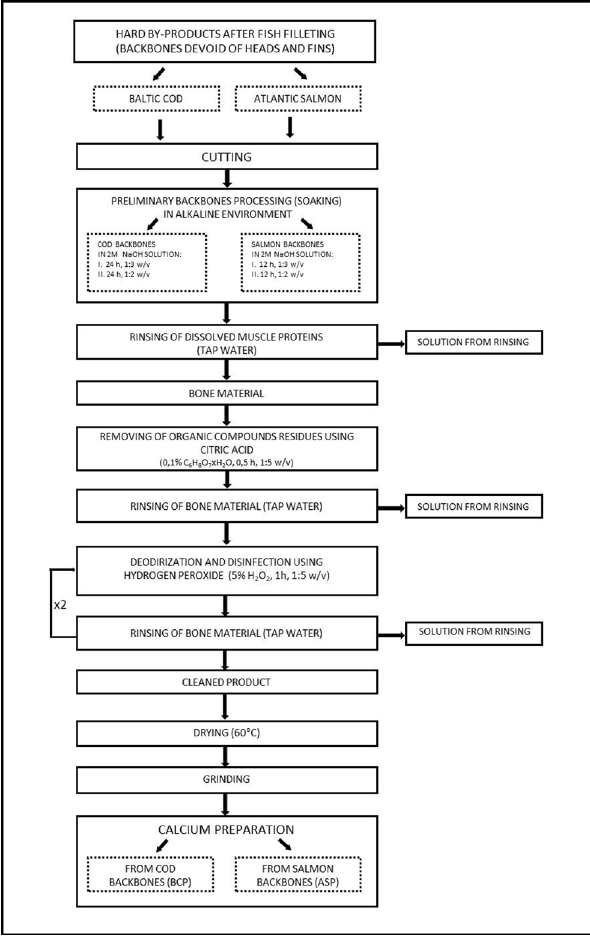
Figure 3: Technology of fish backbones processing on calcium